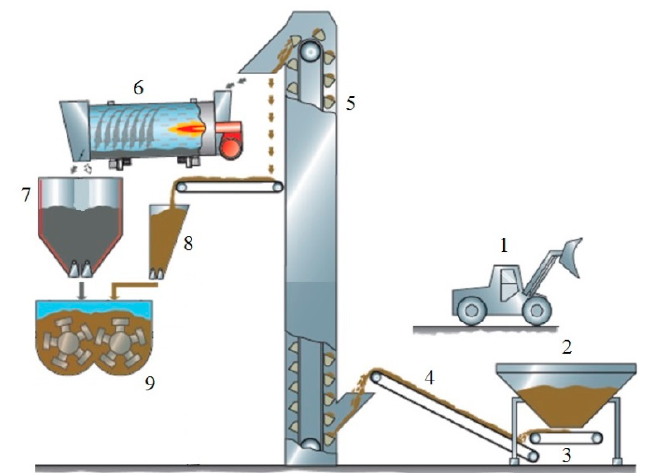
Figure 5. The technological scheme of RAP hot and cold recycling in batch AMP: 1—wheel loader; 2—RAP feeder; 3—belt scale; 4—collecting conveyor; 5—RAP elevator; 6—parallel drum; 7— recycling buffer silo with weighing appliance and recycling scale; 8—cold recycling addition via buffer silo and belt scale; 9—mixer.